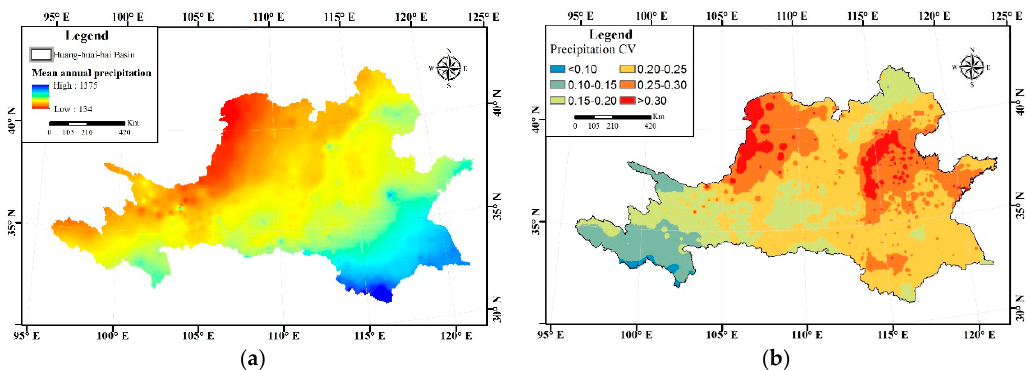
Figure 2. ( a ) Multi-year average precipitation; ( b ) Coefficient variance of precipitation in Figure2. ( a )Multi-yearaverageprecipitation; ( b )Coe ffi cientvarianceofprecipitationinHuang-huai-hai Huang-huai-hai River Basin. River